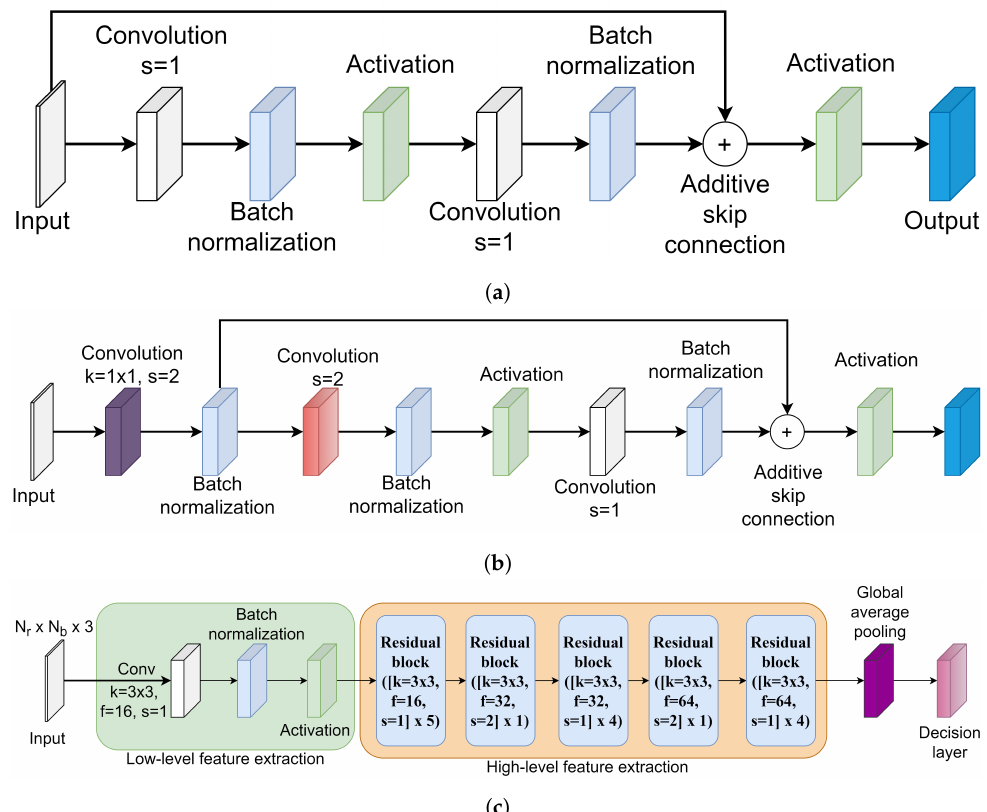
Figure 4. Residual block ([kernel = K × K , filters = F , stride = S ] × R ) means residual blocks are stacked one after another R times and K × K kernel of F filters are used in the convolutional layer. Based on the value of S , one of the residual blocks of Figure 4a,b is selected. ( a ) Architecture of residual block when stride length is set to 1. ( b ) Architecture of residual block when stride length is set to 2. ( c ) Architecture of the